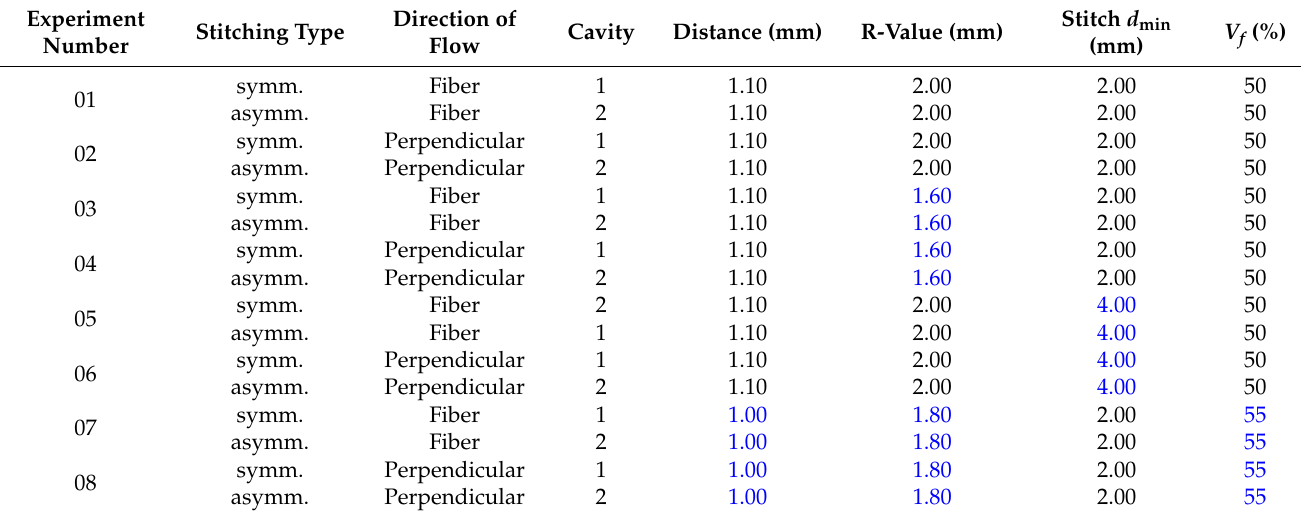
Table 1. Configuration of the different setups of the experimental campaign where the parameters in blue are varied with respect to the base